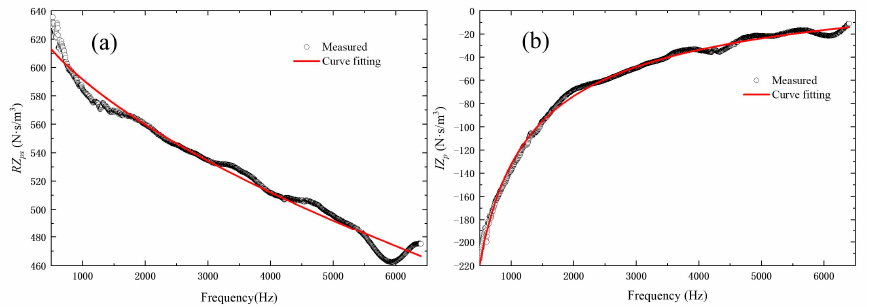
Figure 4. Measured results and curve fitting results of the characteristic impedance of OFC2: ( a ) Real part of measured results and curve fitting results of the characteristic impedance ( RZ ps = − 1.11 × f 0.5859 + 655.1); ( b ) Imaginary part of measured results and curve fitting results of (cid:0) − (cid:1) the characteristic impedance ( IZ ps = i × 8794 × f − 0.5609 + 50.17